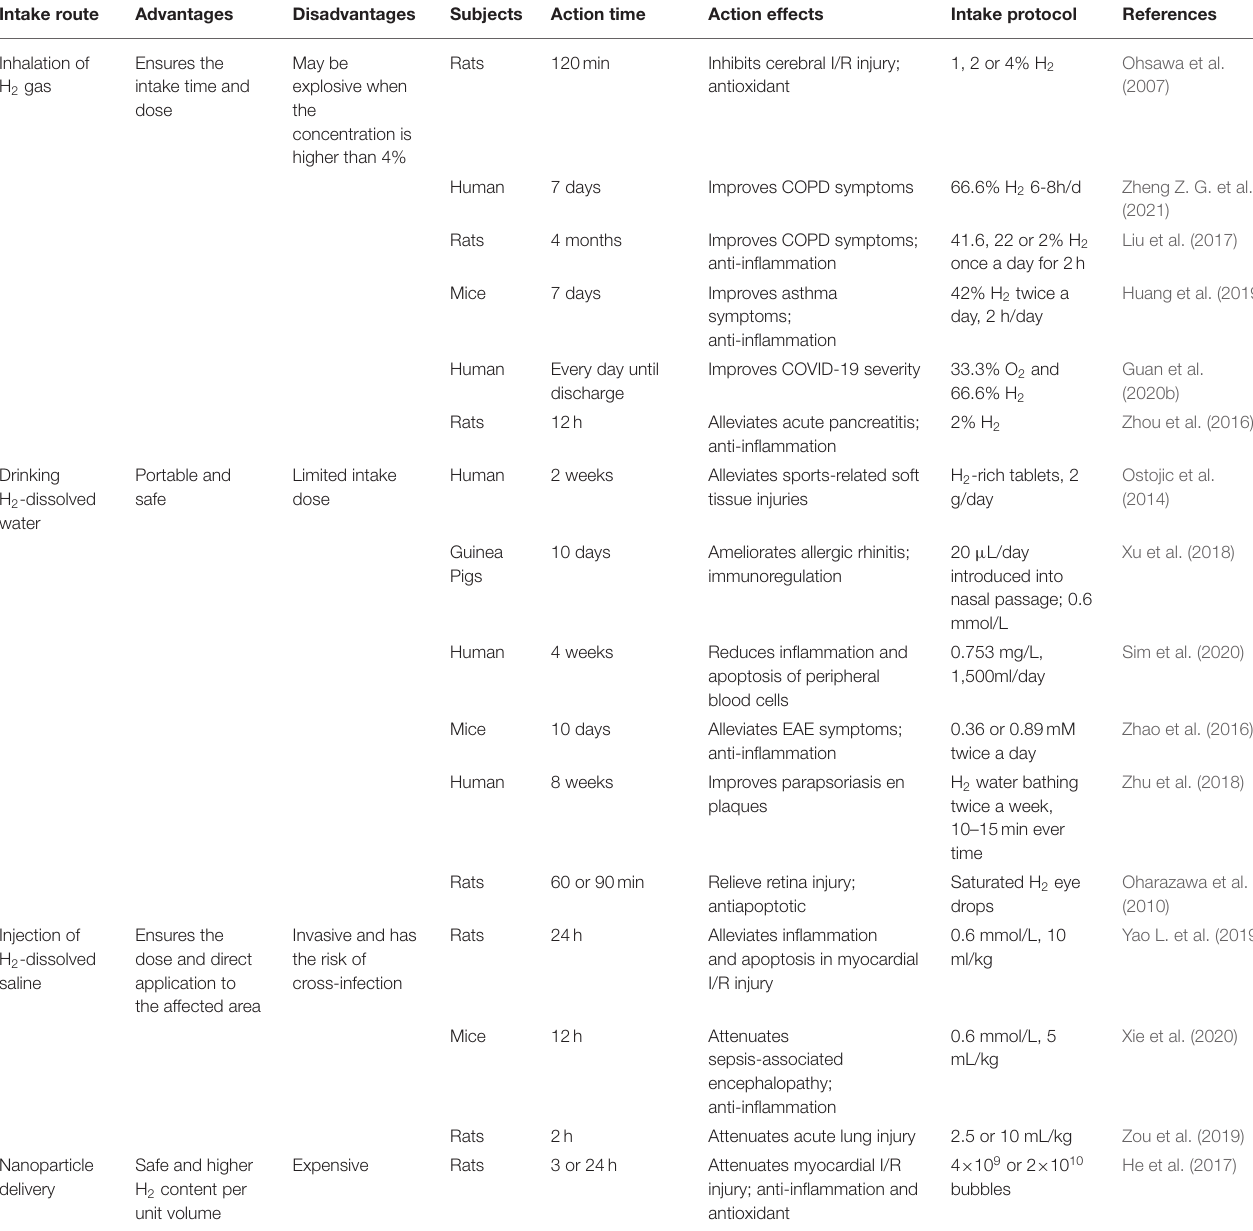
TABLE 1 | H 2 intake route and typical management